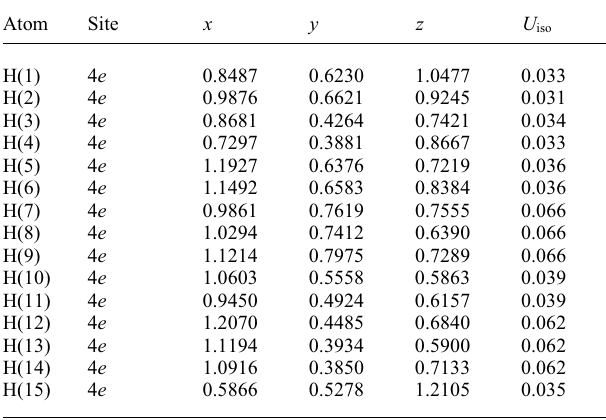
Table 2. Atomic coordinates and displacement parameters (in Å 2 )